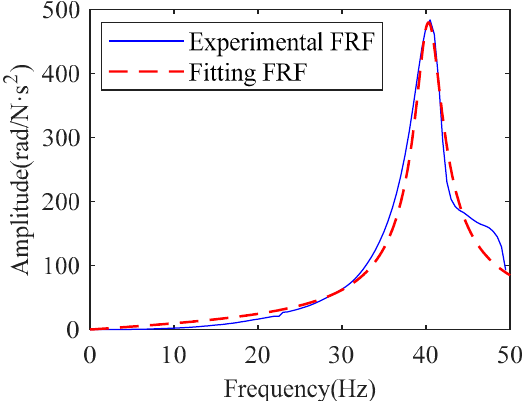
Figure 9. Frequency response function of articulated arm under hammering excitation.